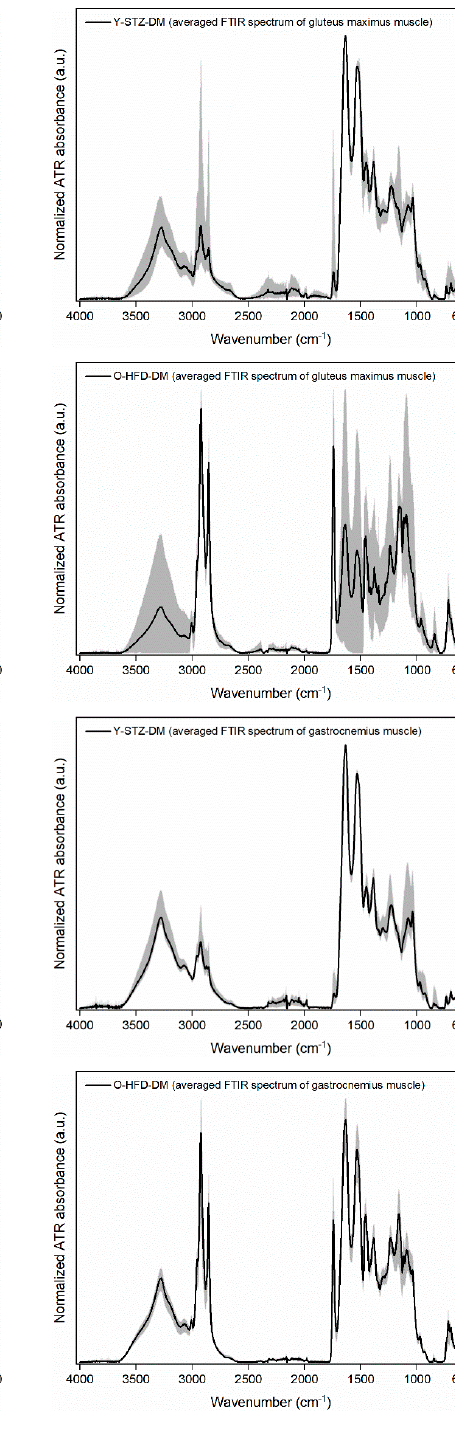
Figure 2. Averaged normalized ATR-FTIR spectra for gluteus maximus and gastrocnemius muscles of 13-week-old non-diabetic mice ( n = 9) (Y-NDM), 13-week-old STZ-induced diabetic mice ( n = 9) (Y-STZ-DM), 54-week-old non-diabetic mice ( n = 9) (O-NDM), and 54-week-old HFD-induced obese insulin-resistant mice ( n = 9) (O-HFD-DM), where the grey shaded area indicates the range between the minimum and maximum intensity at the corresponding